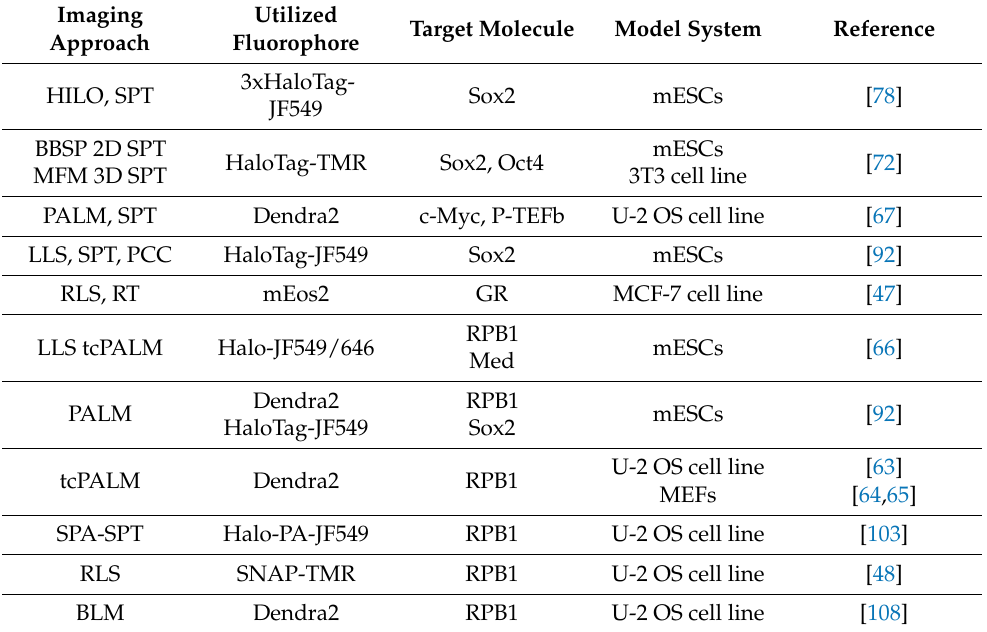
Table 1. Selected exemplar SMLM approaches of tagged TFs and RNAPII in model systems. Abbre- viations are explained in the